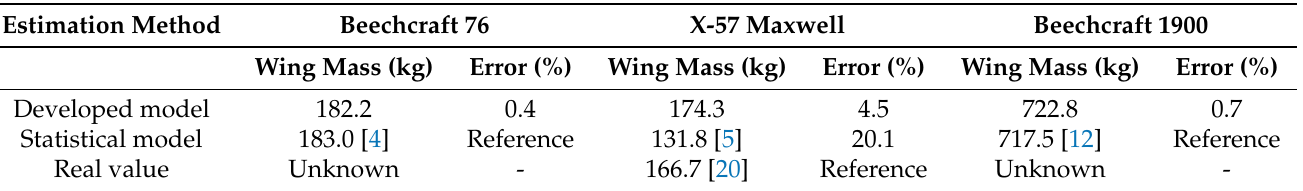
Table 2. Outputs of the presented methodology applied on the Beechcraft 76, the X-57 Maxwell, and the Beechcraft 1900.